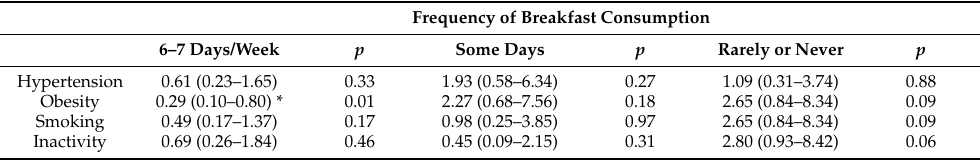
Table 3. Odds ratios (OR) and 95% confidence intervals (CI) for hypertension, obesity, smoking and physical inactivity based on the frequency of breakfast consumption. Frequency of Breakfast